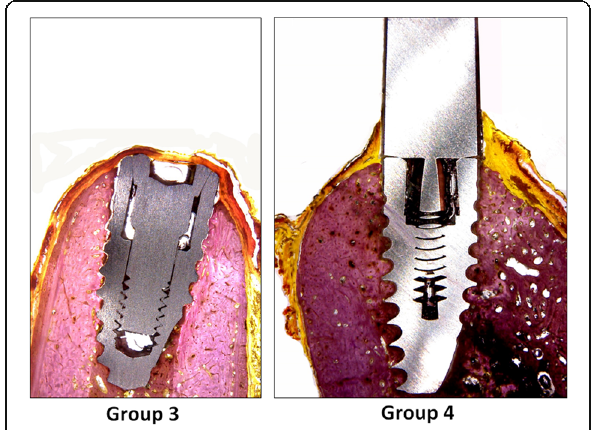
Fig. 4 Images of groups 3 and 4 representing the implants place in healed alveolar sites. Picrosirius red staining. Original magnification